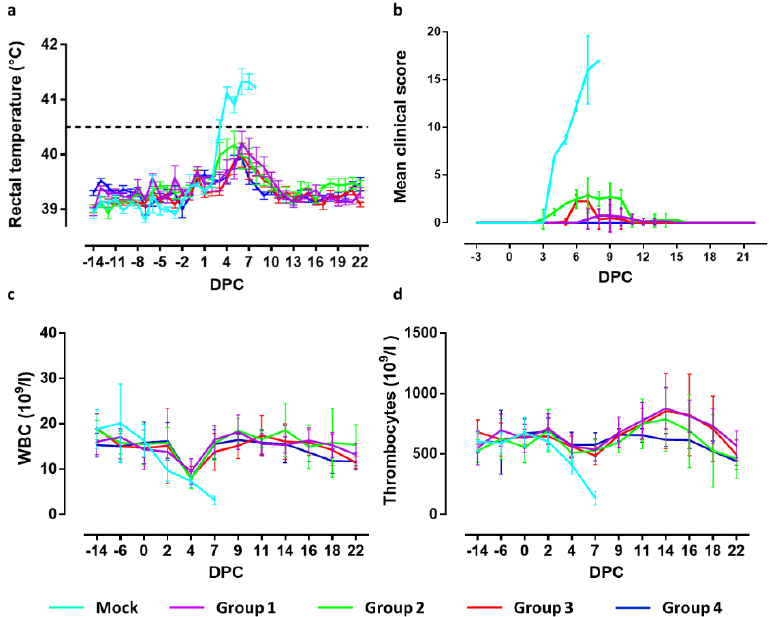
Figure 2. Clinical signs and blood cell counts of mock-vaccinated and C-DIVA-vaccinated animals following challenge infection with the highly virulent CSFV strain Brescia. ( a ) Mean rectal temperatures. Temperature above the dashed line is defined as fever. ( b ) Mean cumulative clinical scores. ( c ) Mean WBC counts. ( d ) Mean thrombocyte counts. Error bars represent SD. DPC; days post challenge.